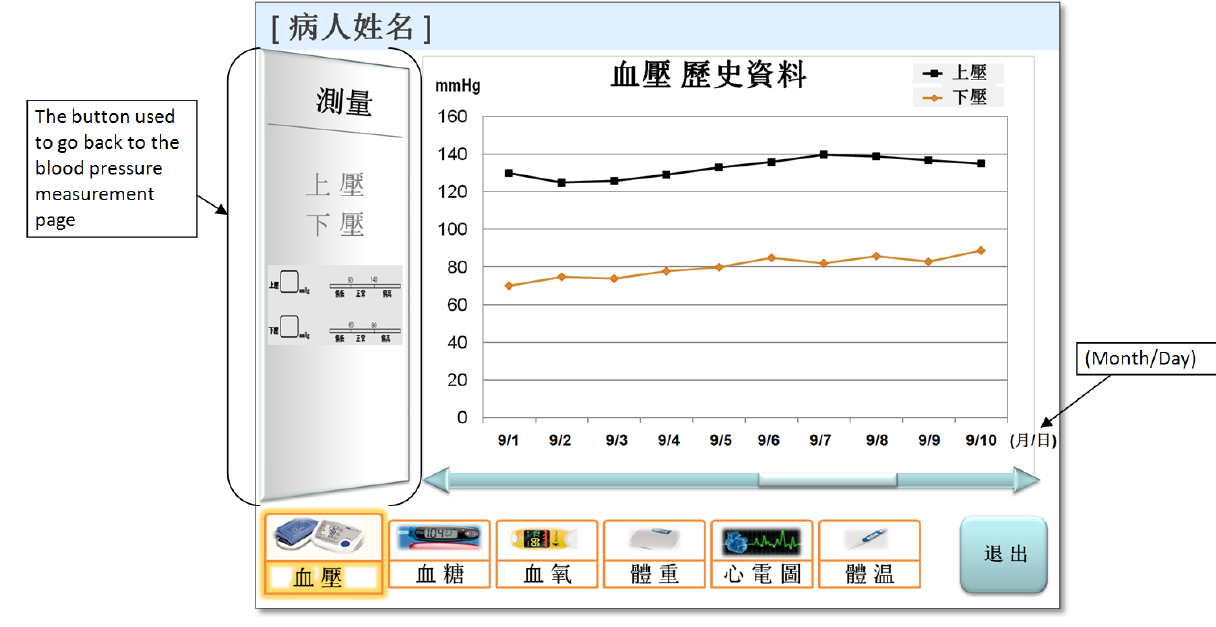
Figure 2. The blood pressure history data page presents the past blood pressure values on a two-dimensional line